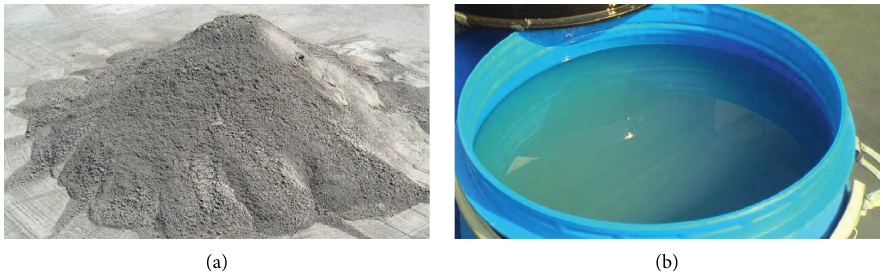
Figure 1: Materials. (a) Portland cement. (b) 801